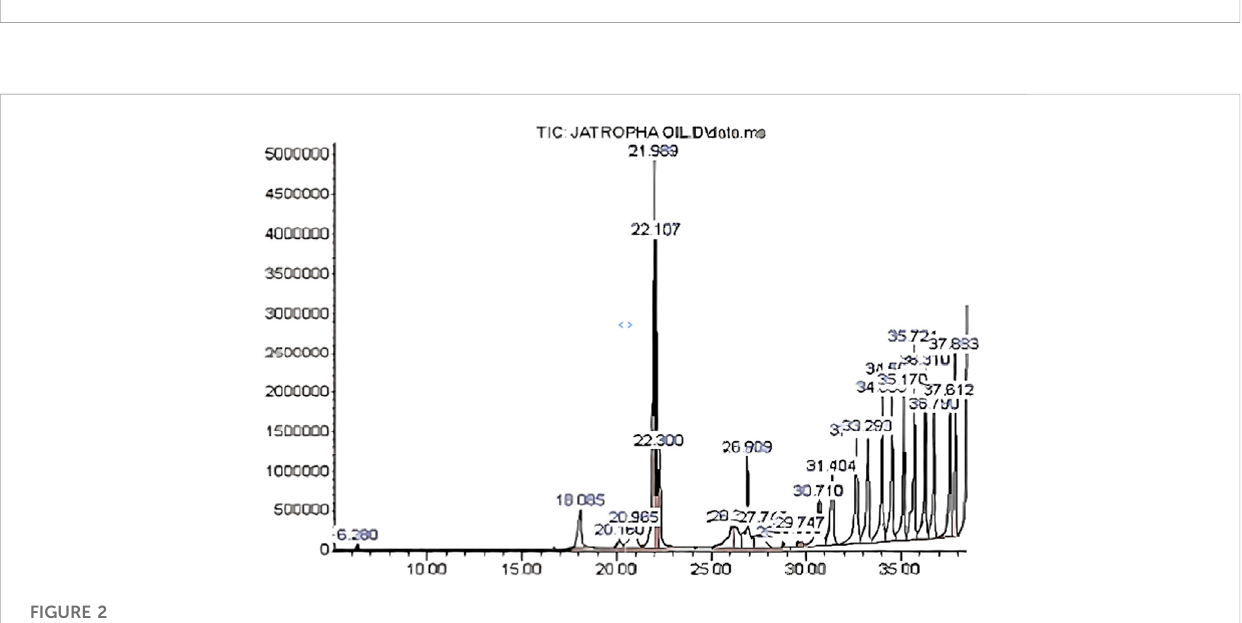
FIGURE 2 GC-MS Analysis on Crude jatropha oil.